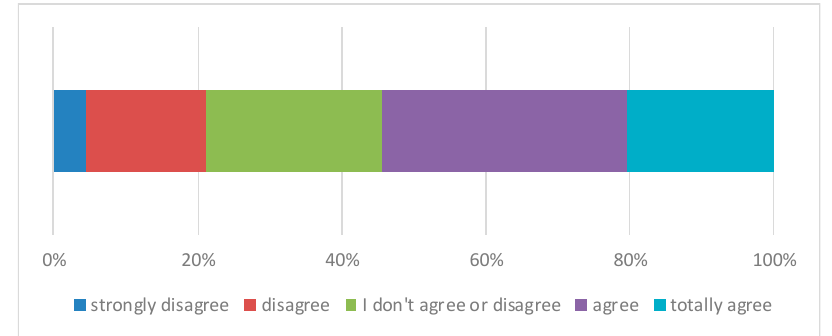
Figure 11. Responses to the statement that the subject matter of the second year of the baccalaureate is too broad.